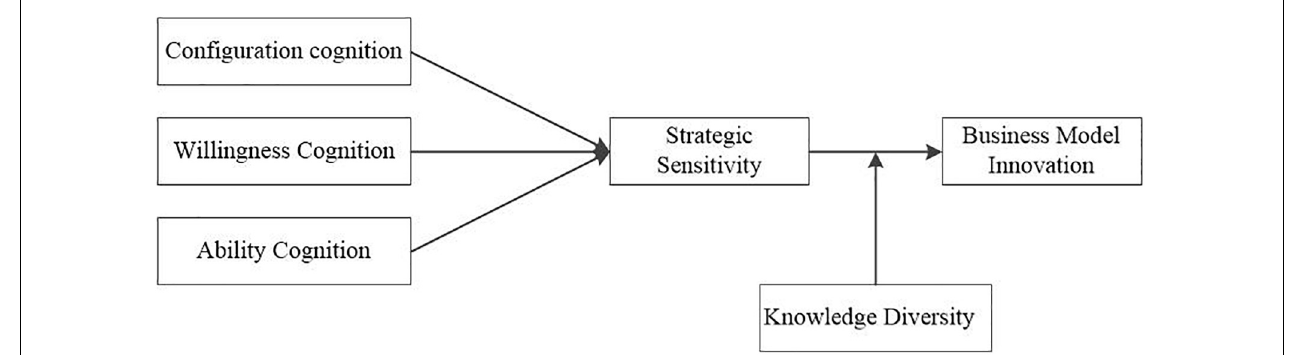
FIGURE 1 | Research